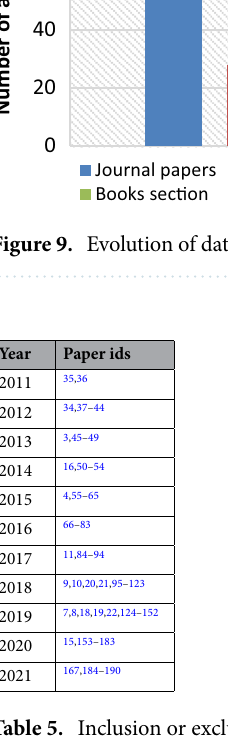
Table 5. Inclusion or exclusion